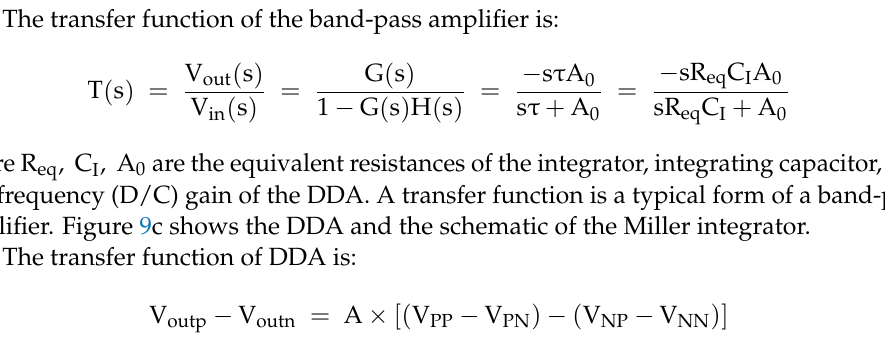
Figure 9. ( a ) The schematic of differential-difference amplifier (DDA) circuit; ( b ) the symbol of a DDA circuit; ( c ) full Y - differential Miller integrator.